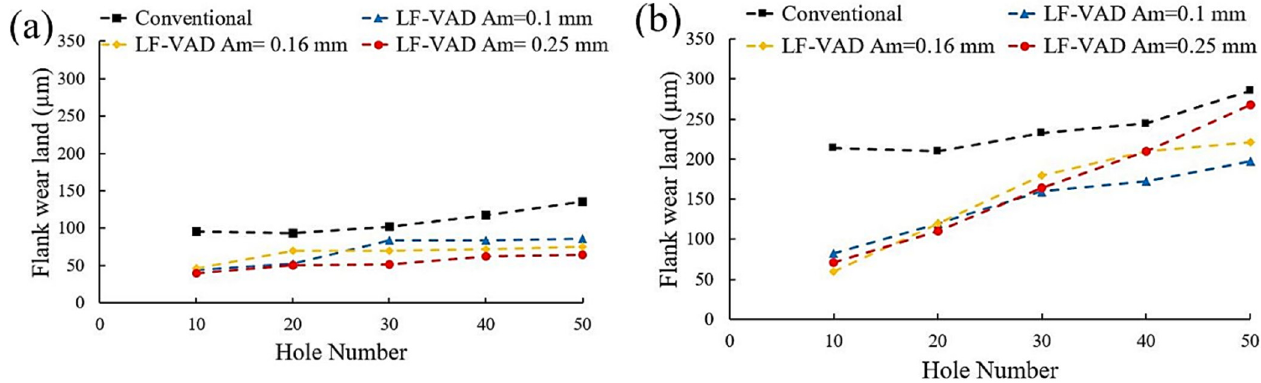
Figure 6. Effect of vibration amplitude on the tool flank wear land for different cutting speeds ( a ) N = 2000 rpm ( b ) N = 3000 rpm.